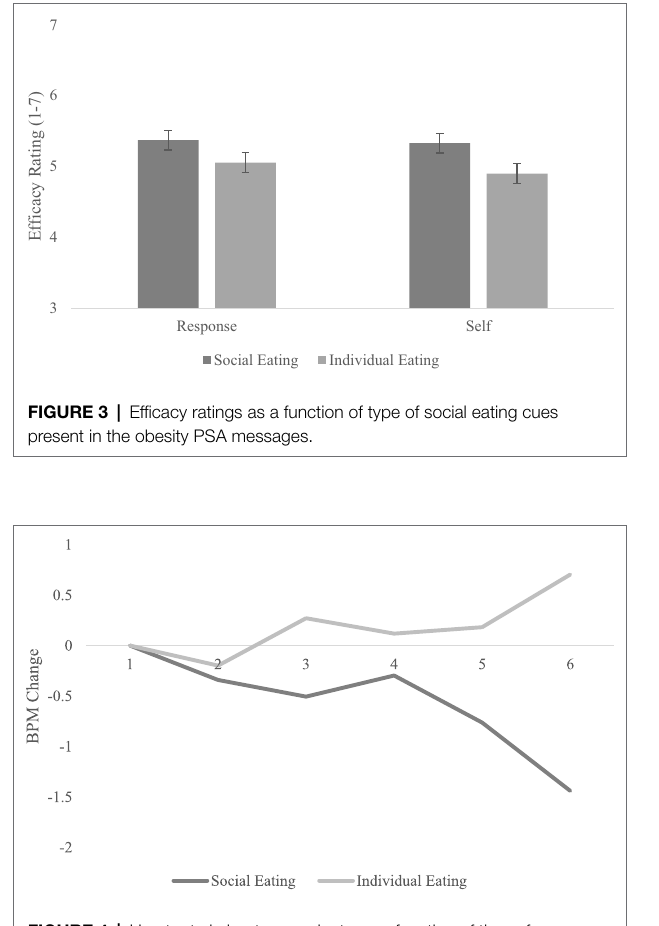
-0.2-0.15-0.1-0.050